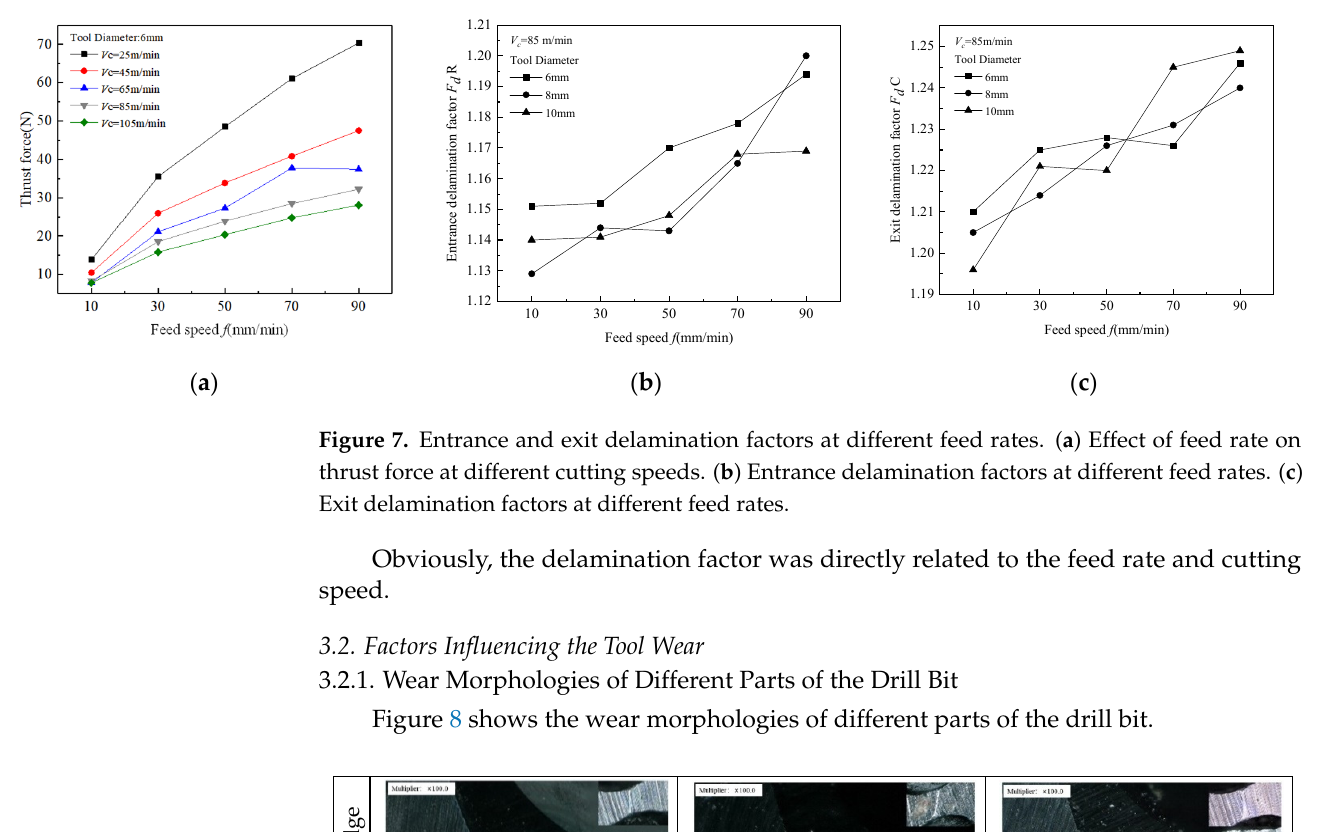
Figure 6. Morphology of entrance and exit at different feed rates ( V c = 85 m/min).